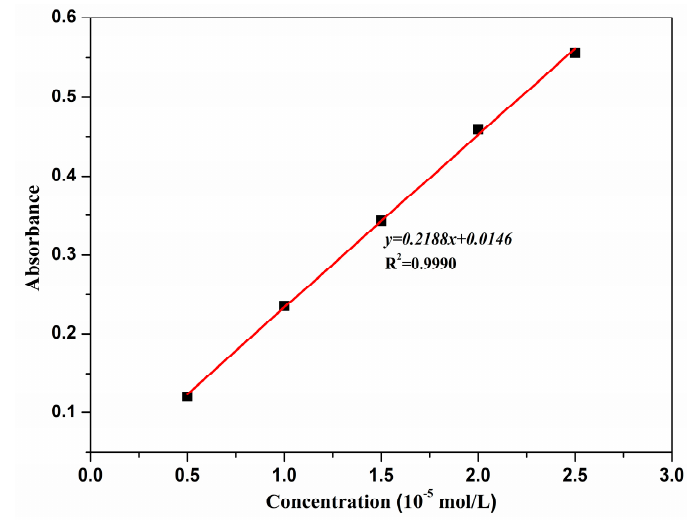
Figure 3. Calibration curve of NaIO 4 as a function of its concentration.